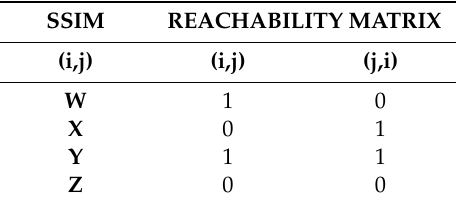
Table 8. Rule adopted for substitution.